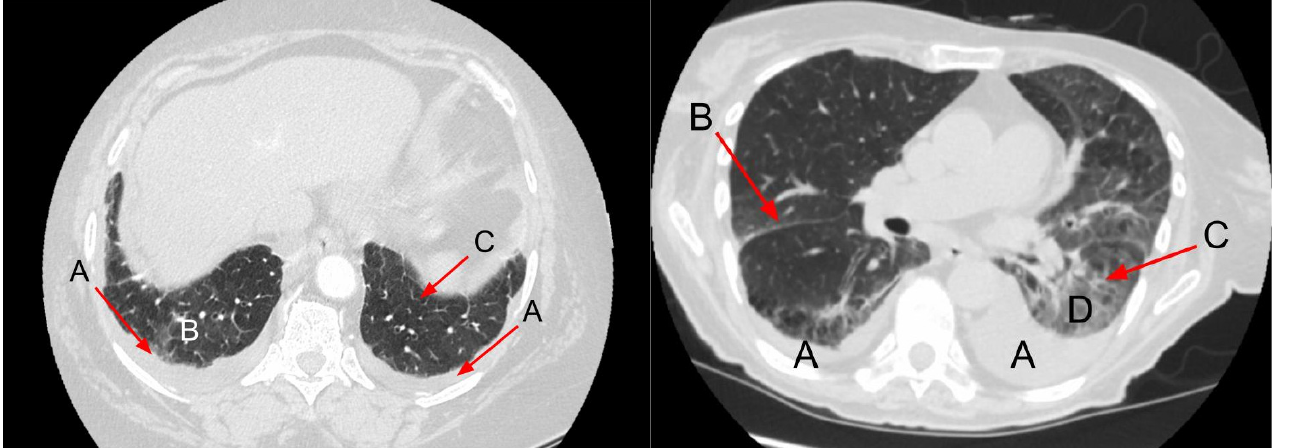
Figure 10. ( left ) Pulmonary findings related to HF in CT. A: Bilateral pleural effusion; B: Ground-glass opacities in gravity-dependent part of the lungs; C: Smooth septal thickening. ( right ) Image of the lungs in HF. A: Bilateral pleural effusion; B: interlobar septal thickening; C: Thickening of interlobular fissures; D: Ground-glass opacities in gravity-dependent part of the lungs. Figure obtained with permission from the 2nd Department of Radiology, Medical University of Warsaw.